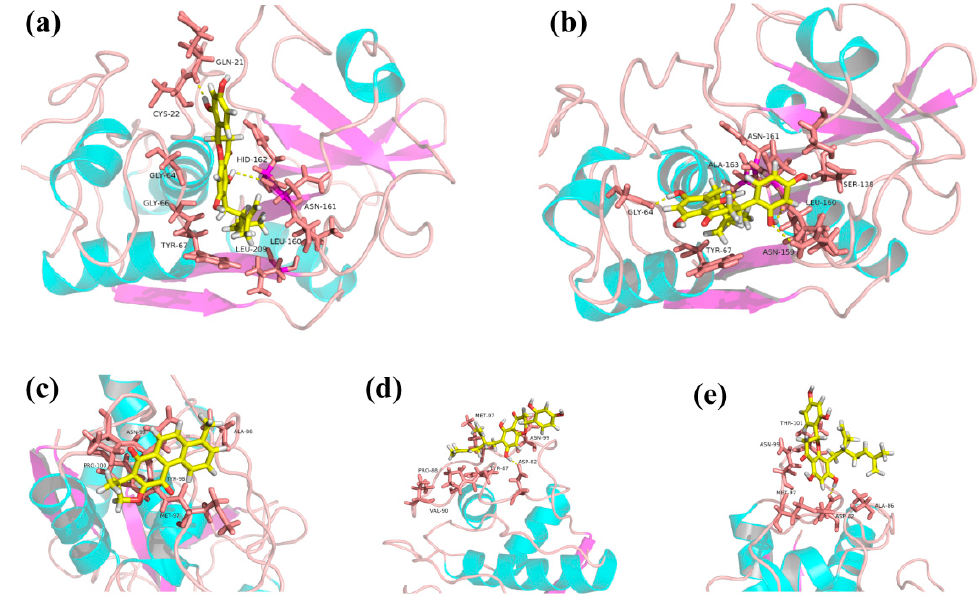
Figure 8. Binding modes of KF and SG in the active site or exosite 1 of Ctsk after 10 ns of MD simulation. The structures of compounds were represented in stick model with color (yellow: carbon atom, red: oxgen atom and white: hydrogen atom). The protein was shown in the cartoon representation, the key residues in the active site were also represented as stick model with color (blue, red, and gray), the yellow dashed line denoted protein-ligand H-bonding interactions. ( a ) KF bound to active site of Ctsk; ( b ) SG bound to active site of Ctsk; ( c ) DHT (as a reference compound) bound to the exosite1 of Ctsk; ( d ) KF bound to the exosite1 of Ctsk; ( e ) SG bound to the exosite1 of Ctsk.